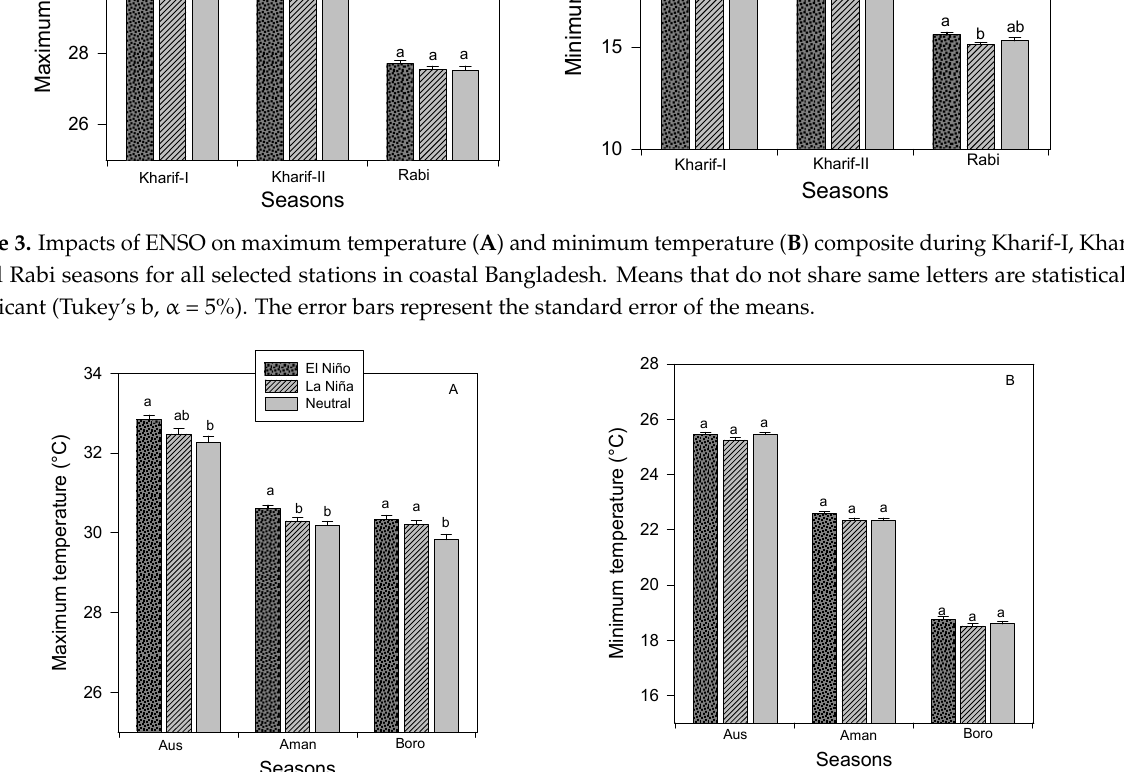
Figure 4. Impacts of ENSO on maximum temperature ( A ) and minimum temperature ( B ) composite during Aus, Aman, and Boro seasons for all selected stations in coastal Bangladesh. Means that do not share same letters are statistically significant (Tukey’s b, α = 5%). The error bars represent the standard error of the means.